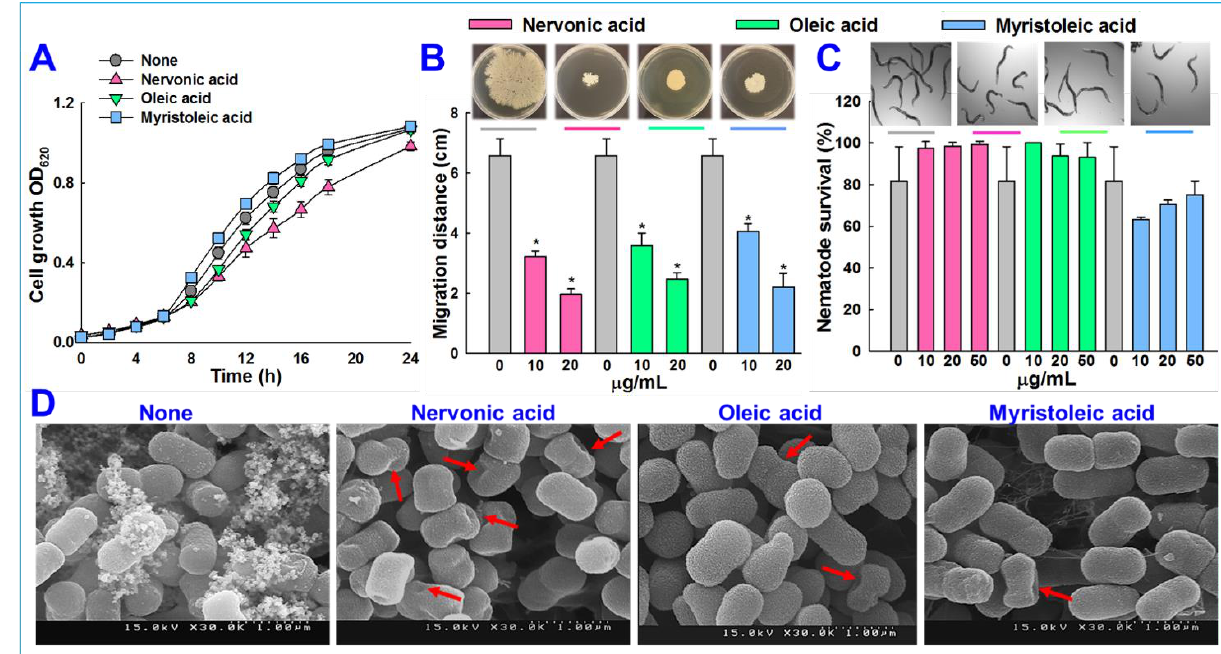
Figure 2. A. baumannii ATCC 17978 cell growth was investigated in the presence of nervonic, oleic, or myristoleic acid at 20 μg/mL ( A ), A. baumannii ATCC 17978 motility was assessed in the presence of fatty acid at 20 μg/mL after incubation for 24 h ( B ), the cytotoxicity of fatty acid was evaluated against C. elegans ( C ), A. baumannii ATCC 17978 biofilm formations on nylon membrane were observed by SEM in the presence of fatty acid at 20 μg/mL. Red arrows indicate dents in cells and scale bars represent 1 µm ( D ). Error bars indicate standard deviations. *, p < 0.05 versus non-treated controls.